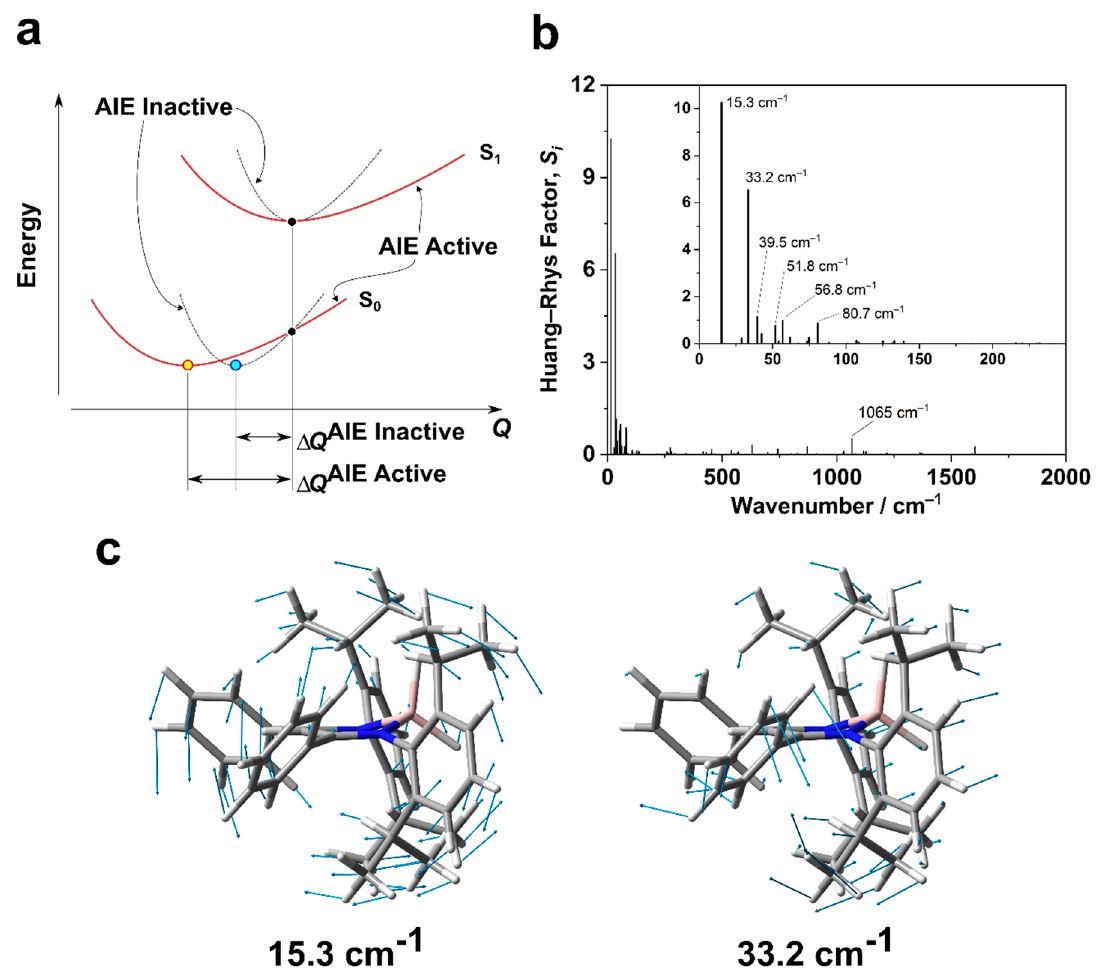
Figure 5. ( a ) Schematic representation of potential energy surface diagrams of typical AIE-active and -inactive molecules. Q means reaction coordinates. ( b ) Calculated Huang–Rhys factors, S i , versus the normal modes for LAlH . Inset shows an enlarged view of the low-frequency region. The marked normal modes have relatively large HR factors ( S i > 0.5). ( c ) Displaced vectors for the vibrational